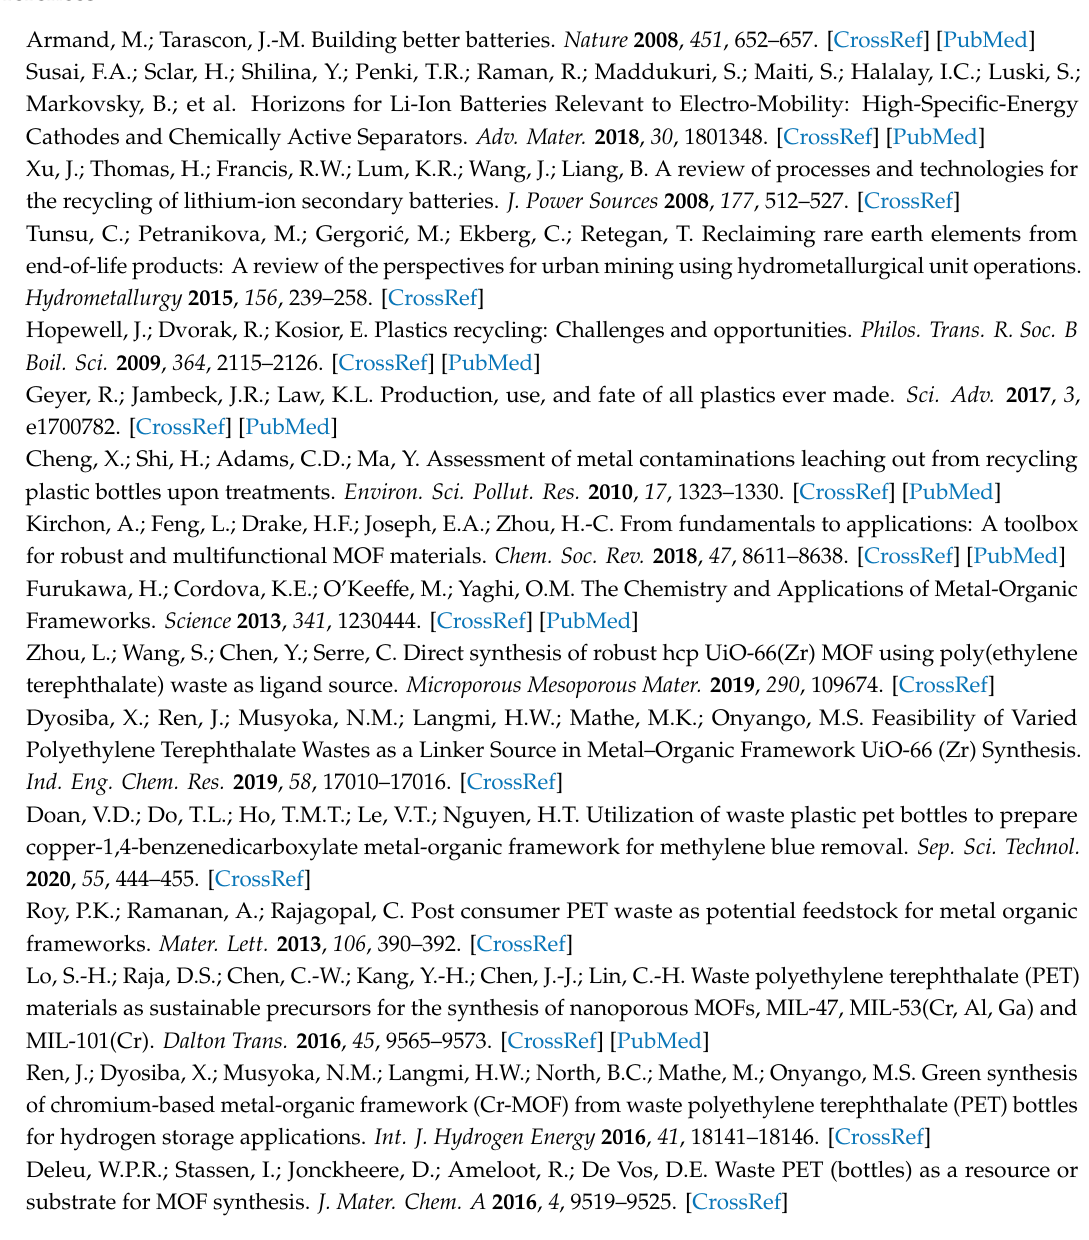
Figure S1: 1 H NMR spectra obtained after the alkaline treatment of the PET plastic, Figure S2: SEM image of the material obtained at 70 ◦ C, Table S1: EDX analysis of the material obtained at 70 ◦ C, Table S2. EDX analysis of the material obtained at 90 ◦